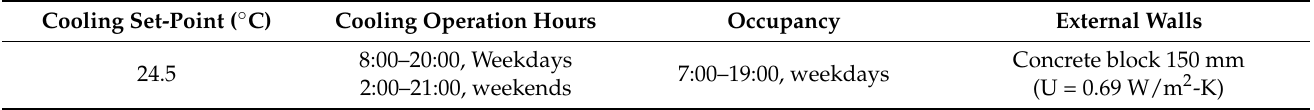
Table 8. Optimal solutions selected for the case study.